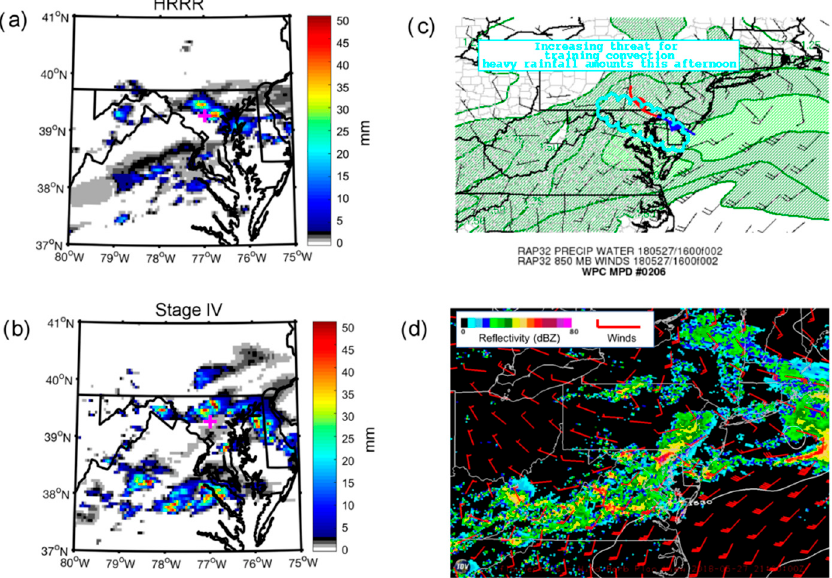
Figure 10. Summary for 27 May 2018: ( a ) Stage IV one-hour precipitation totals valid for the period ending 21 UTC 27 May ( b ) 15 UTC HRRR one-hour precipitation forecast valid for the period ending 21 UTC 27 May ( c ), WPC analysis associated with a mesoscale precipitation discussion issued at 13:36 EDT on 27 May 2018, and ( d ) 15 UTC HRRR forecast 850 mb winds (red vectors), geopotential heights (white contours), and model simulated composite reflectivity valid at 21 UTC May 27 (image made in IDV).